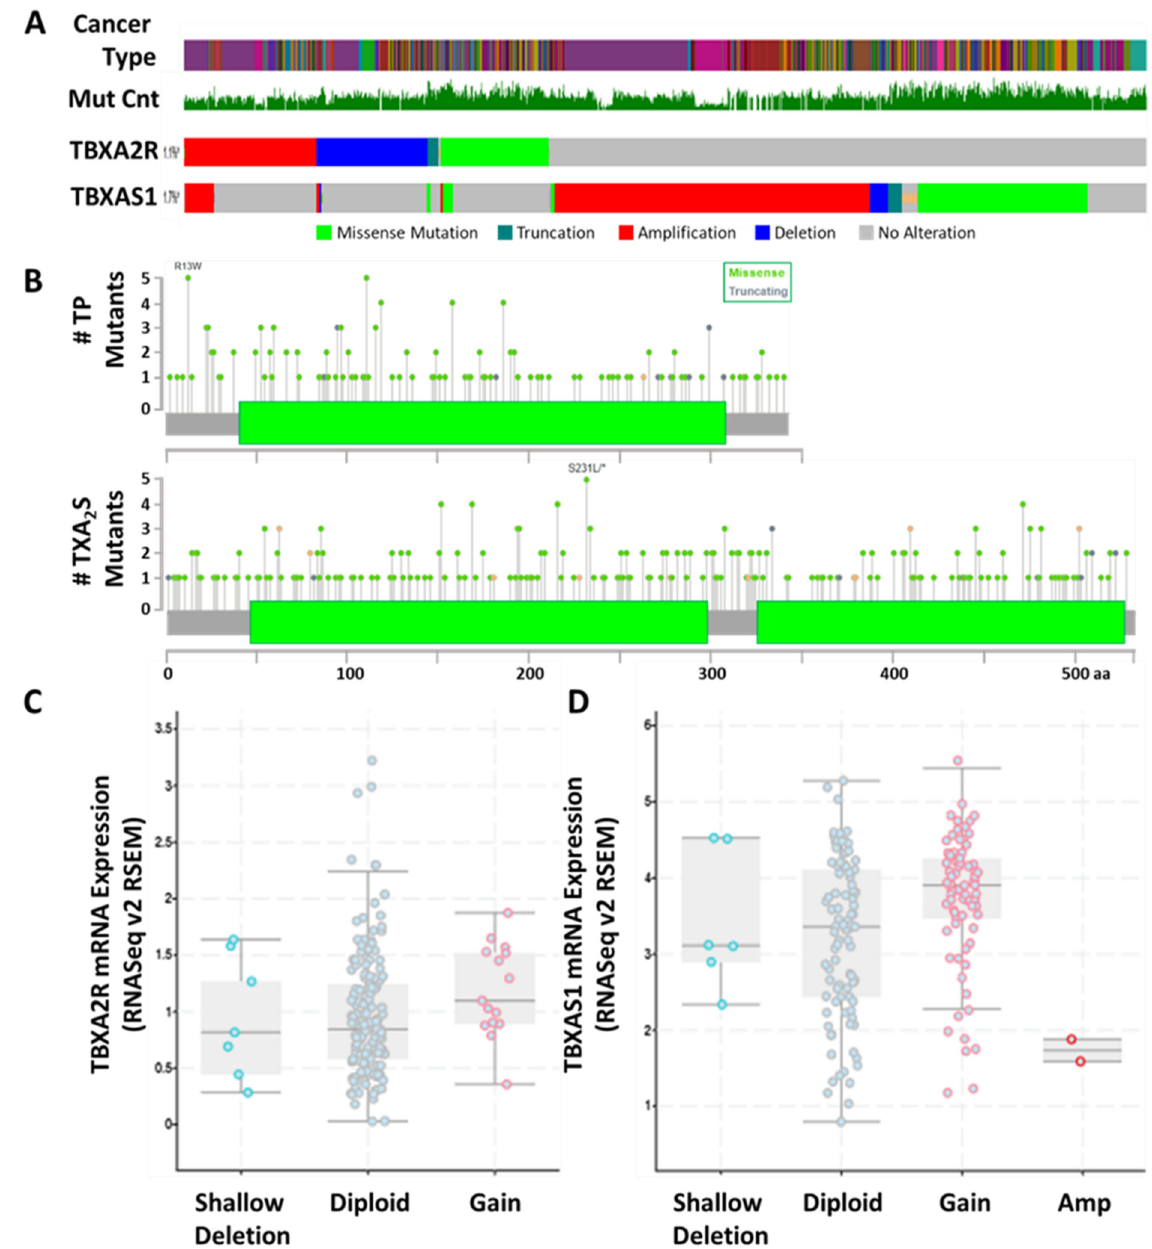
Figure 5. TBXA2R and TBXAS1 are Genetically Stable Targets for Anti-Cancer Therapy. ( A ) Mutational analysis of TBXA2R and TBXAS1 mutants from the TCGA pan-cancer dataset. The different types of cancer in the analysis and the average total mutation count (MutCnt) for each patient are shown. Gain ( ) and loss ( ) of copy number are differentiated from missense ( ) and frameshift (truncation, ) mutations. ( B ) Schematic of TP α and TXA 2 S showing the position of the most frequent mutations and how many times they occurred in (A). The 7 transmembrane regions of TP and active domains of TXA 2 S ( ) are shown for reference. ( C , D ) Correlation of change in copy number with mRNA expression for TBXA2R ( C ) and TBXAS1 ( D ) indicates whether changes in copy number are required for changes in transcription of both genes in cancer.